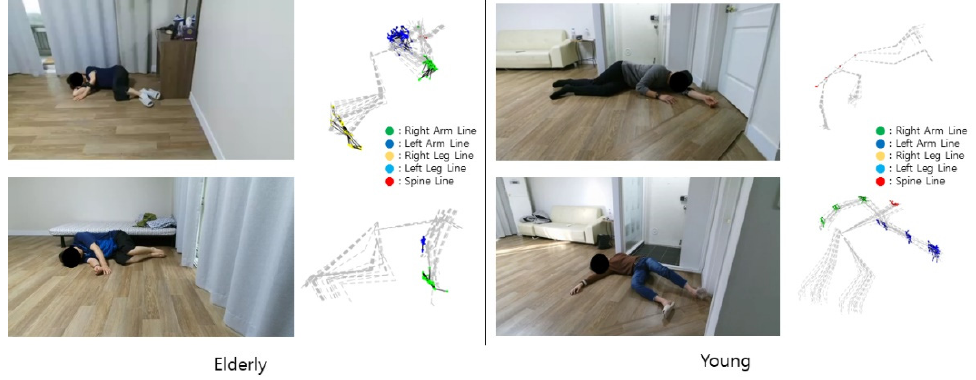
Figure 10. Difference matching analysis of skeleton-heatmaps between elderly people and young adults for the behavior of falling on the floor.